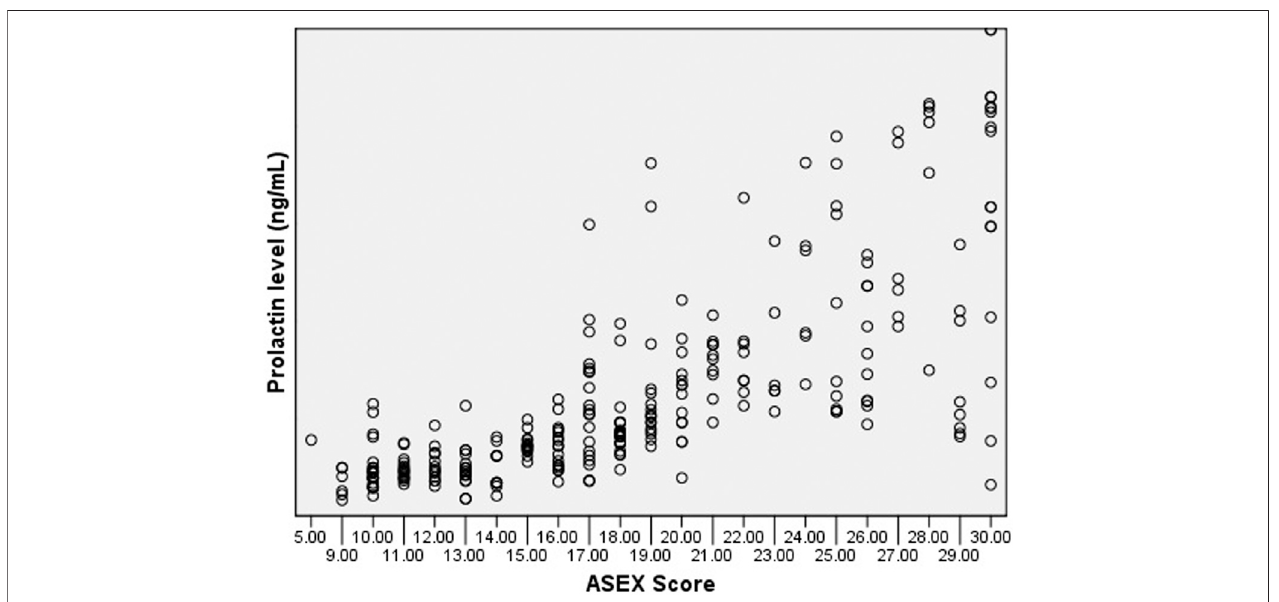
FIGURE 1 | The scatter plot of ASEX score and prolactin